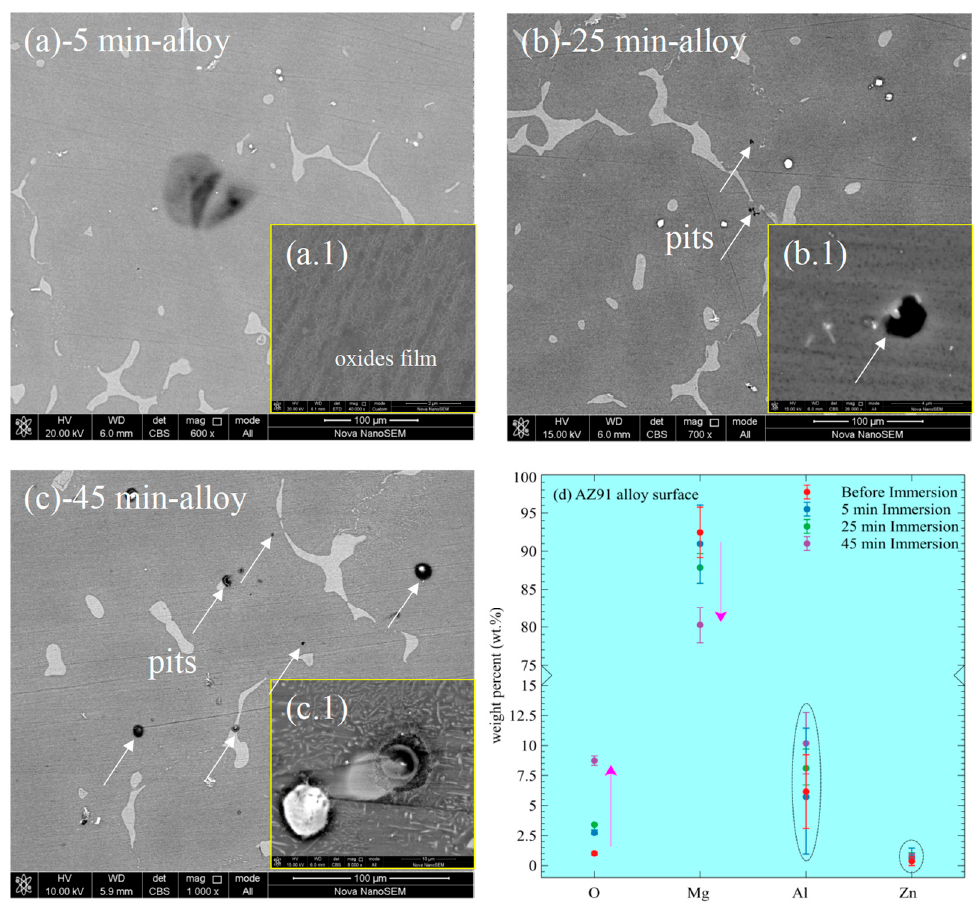
Figure 7. Corrosion morphology of AZ91 alloy and MAO-coated alloy for different immersion times in 3.5% NaCl solution. ( a – c ) the alloy surface morphology after 5, 25, and 45 min immersion; (a.1–c.1) the localized corrosion morphology, and ( d ) the weight percent (wt.%) of the elements on the corroded surfaces.